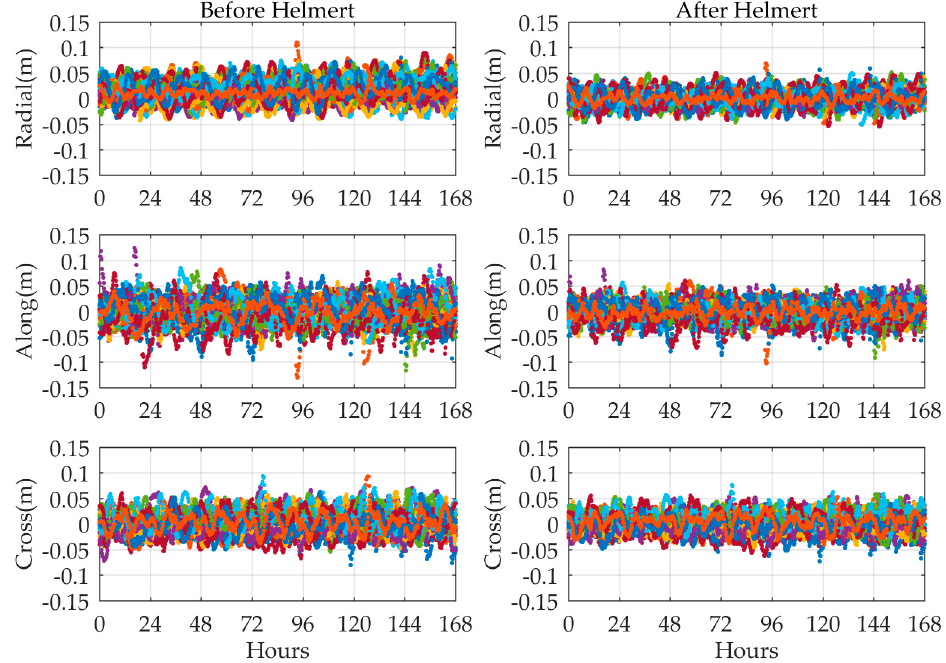
Figure 3. Time series of the MADOCA real-time GPS satellite orbit errors in radial and along/cross-track directions from 11 November 2018 to 17 November 2018.